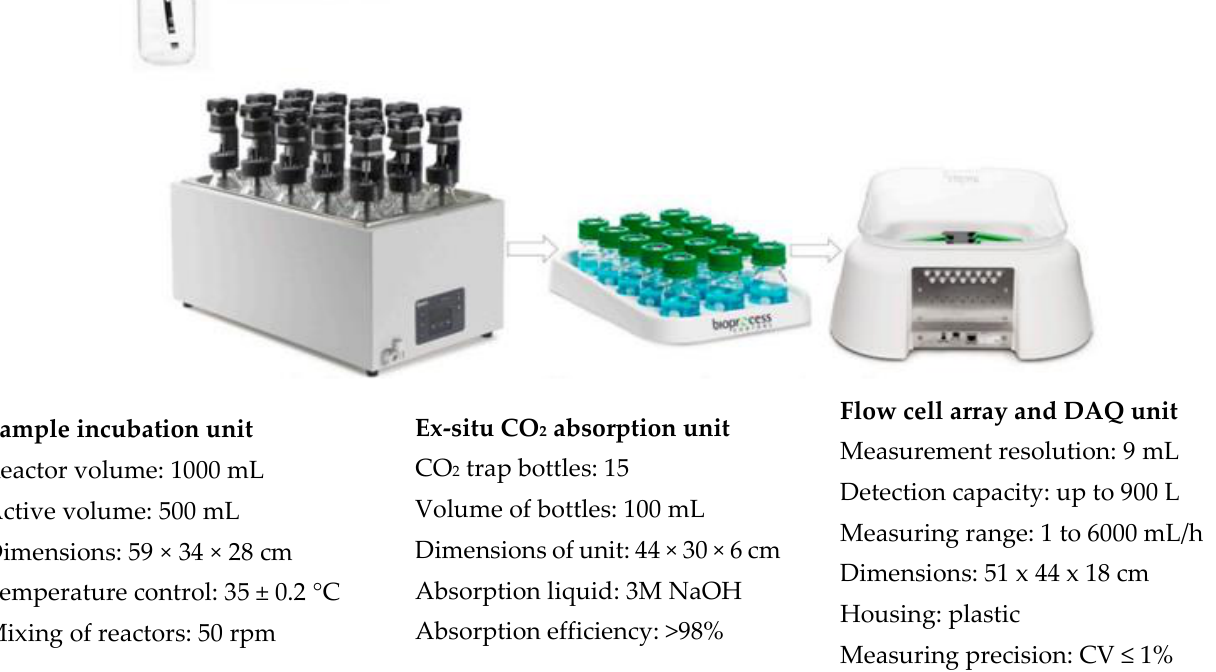
Figure 2. Schematic diagram of the experimental station in stage 1.